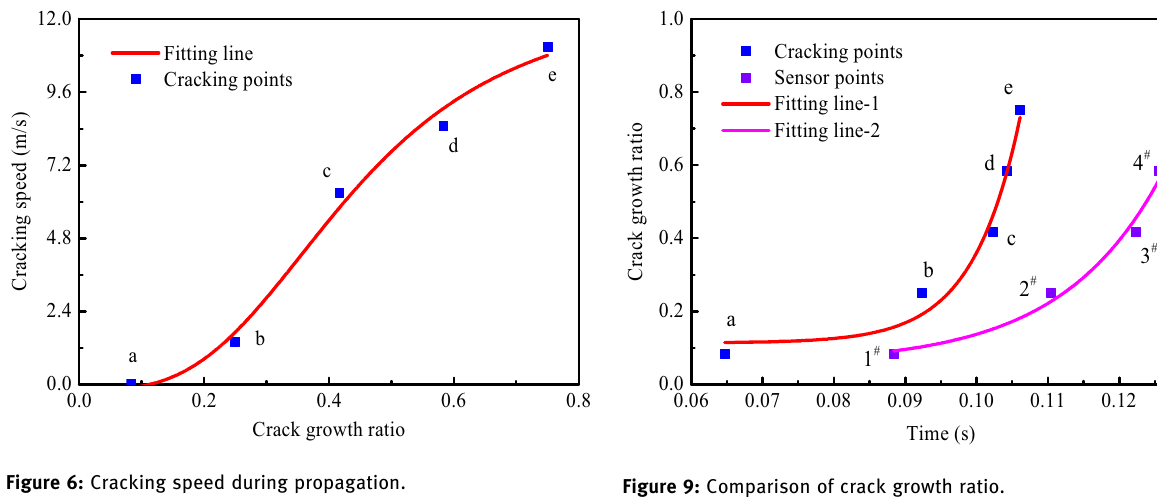
Figure 9: Comparison of crack growth ratio.